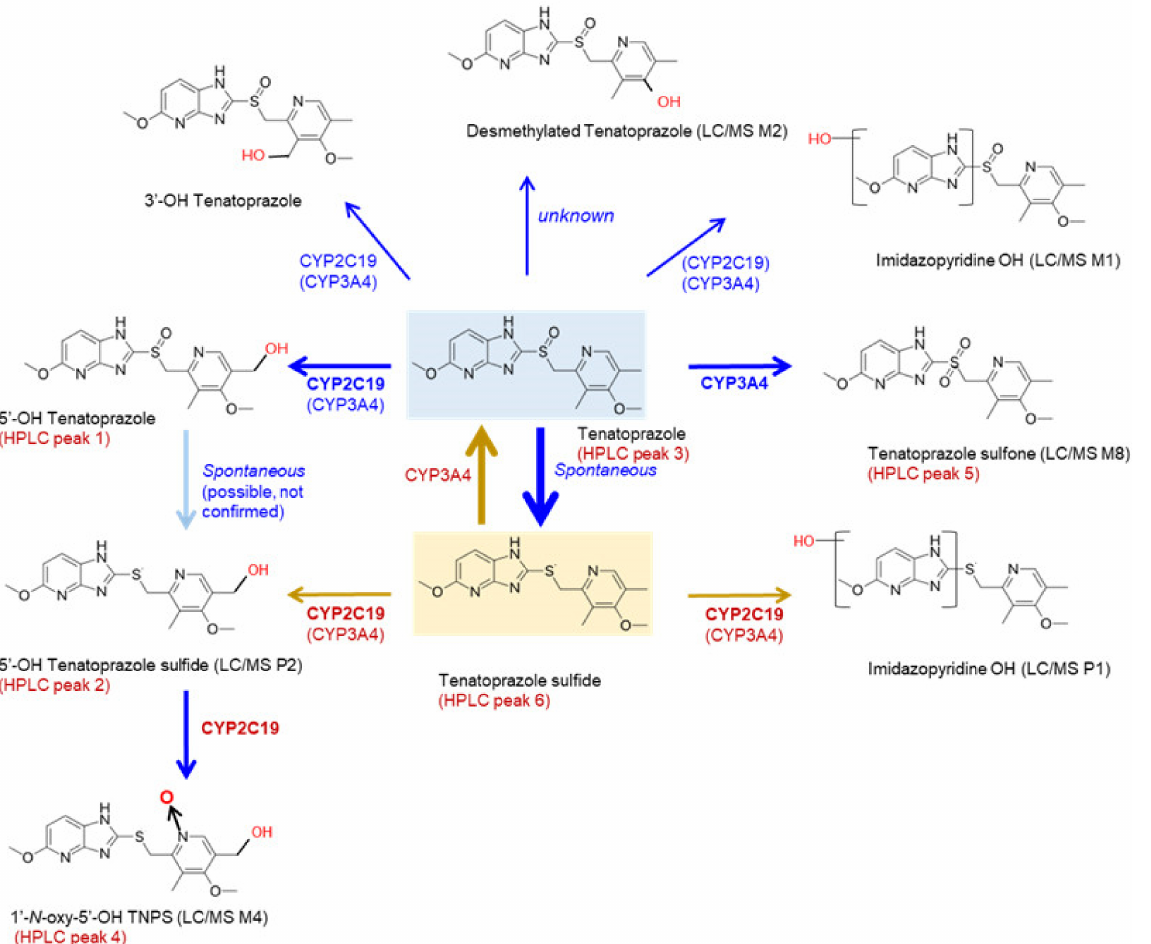
Figure 7. A possible scheme for tenatoprazole metabolism in human liver microsomes. Notes were added to match the HPLC metabolites (Figure 2) with LC-QTOF metabolite (Figure S2). Nonenzy- matic spontaneous desulfoxidation of 5 (cid:48) -OH tenatoprazole to 5 (cid:48) -OH tenatoprazole sulfide is possible but experimental evidence was not provided in this